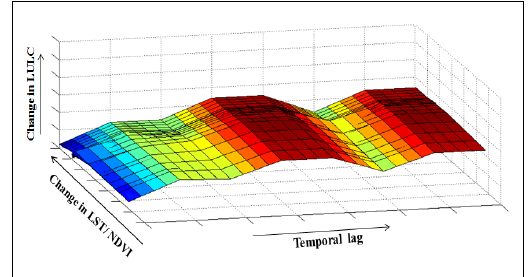
Figure 8. Spatio-semantic cross-semivariogram with respect to LST and NDVI